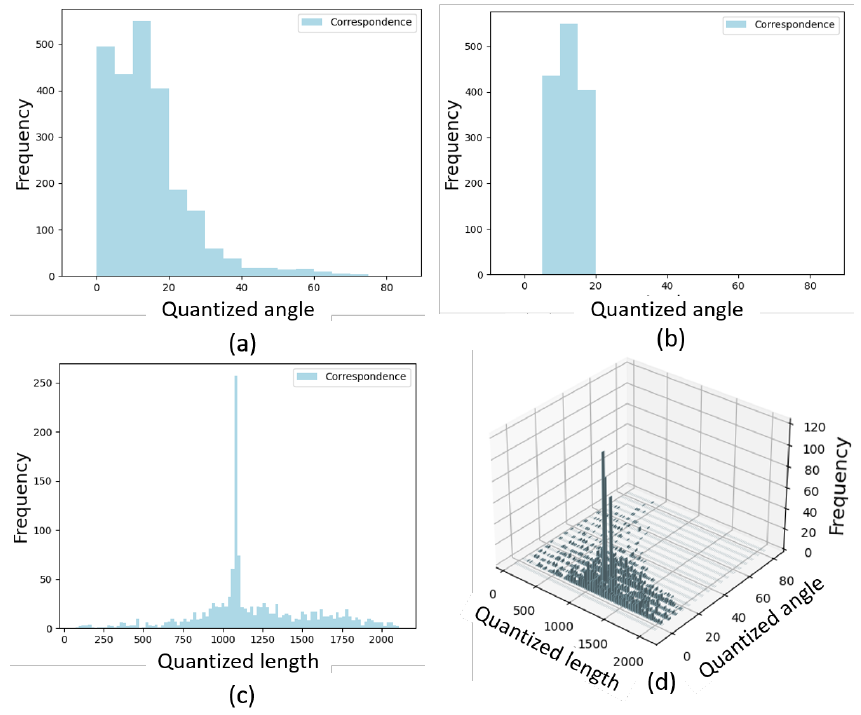
Figure 2. The construction of a reduced correspondence set C reduced , GH for one image-pair in the “Airport” dataset. ( a ) The quantized orientation histogram of C ini . ( b ) The quantized orientation histogram of the tentative reduced correspondence set C θ ,1 . ( c ) The quantized length histogram of ( b ). ( d ) The histogram of the reduced correspondence set C reduced , GH